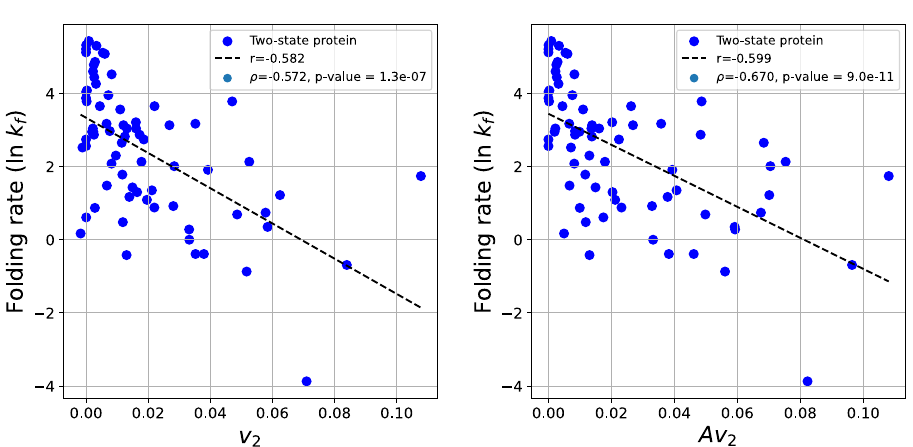
Figure 9. The protein folding rate as a function of the v 2 (left) and Av 2 /N (right) of the set of two-state